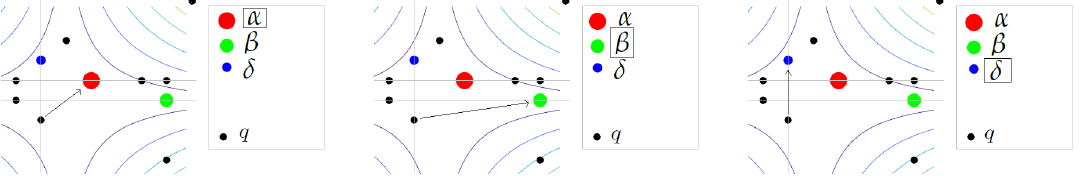
Figure 8. Continuous GWO: displacement of an agent q towards the center of mass of the leaders.